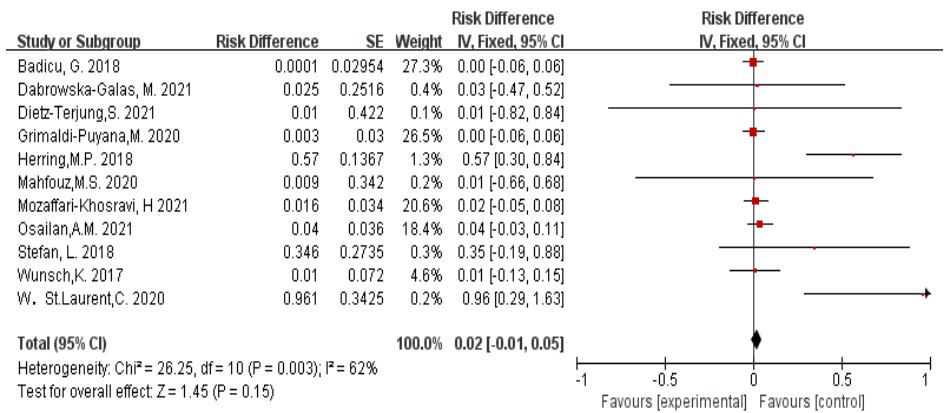
Figure 2. Forest graph showing the overall effect of exercise on sleep disorders [22–32].